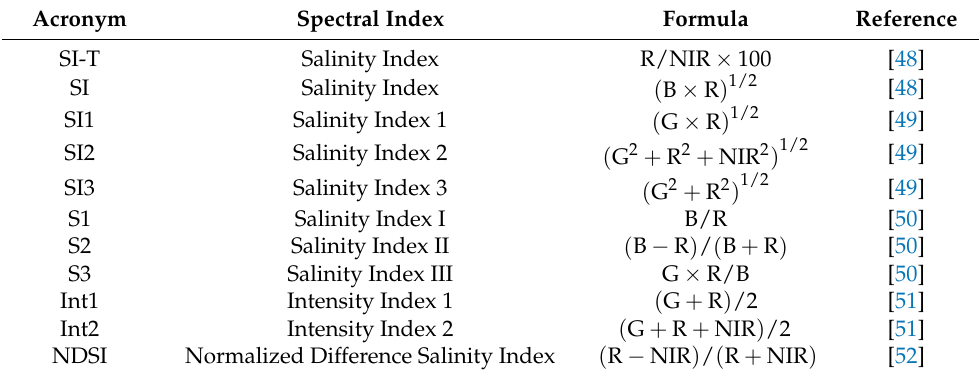
Table 1. Reference overview of studies of spectral salinity indices and formula.